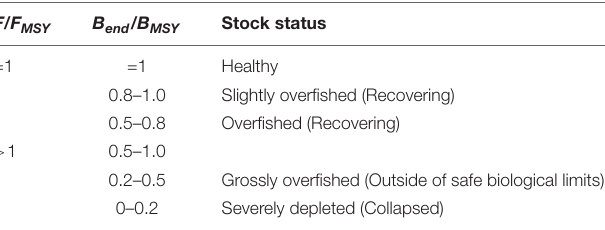
TABLE 4 | Definition of fish stock status, based on F/F MSY and B / B MSY in the final year of a time